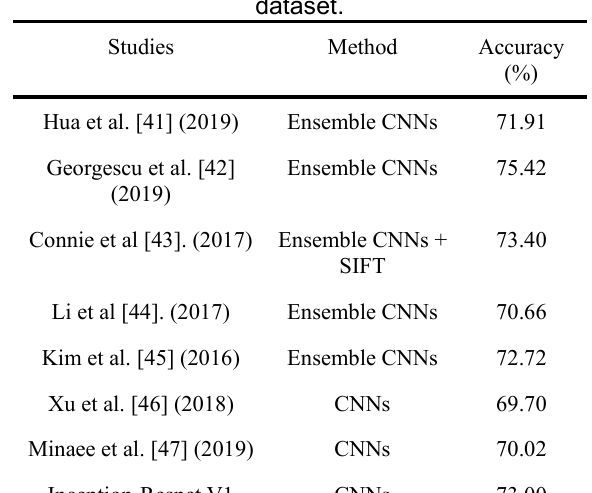
Table 5. Results of 7 expressions on the FER2013